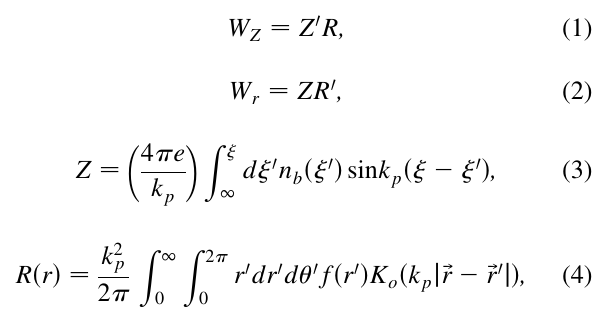
sponse to an arbitrary relativistic bunch profile n